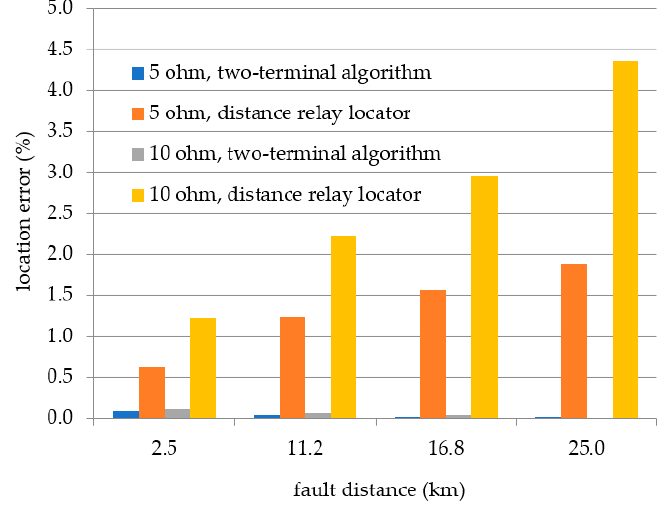
Figure 9. The errors comparison between the proposed algorithm and the distance relay locator.